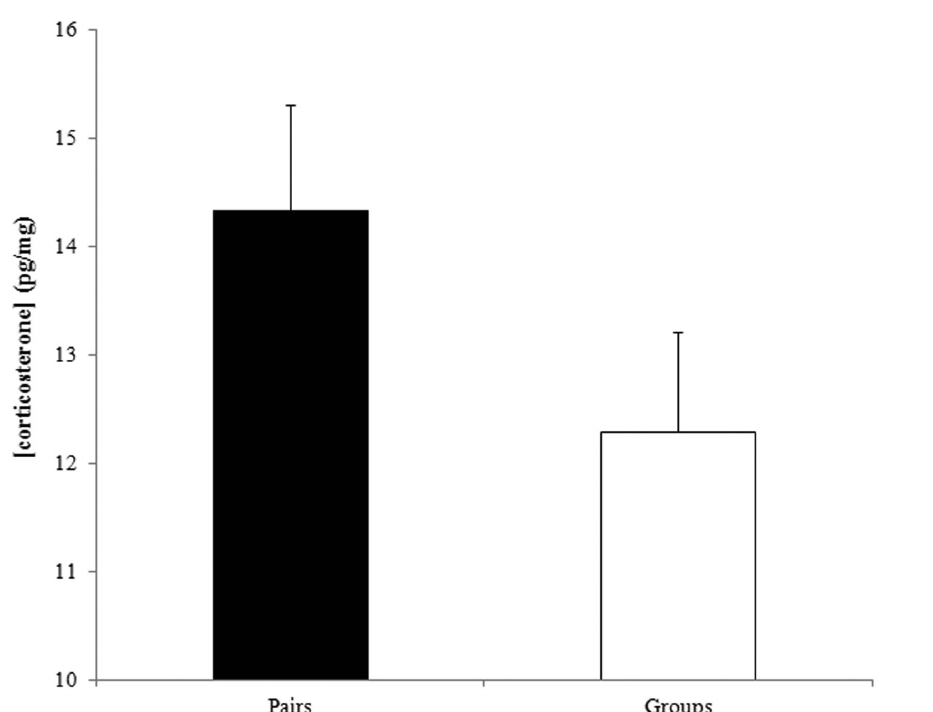
Figure 4. There was a significant decrease in first eggs yolk corticosterone levels (means and SE are shown) between clutches raised in pairs and clutches raised with helpers.